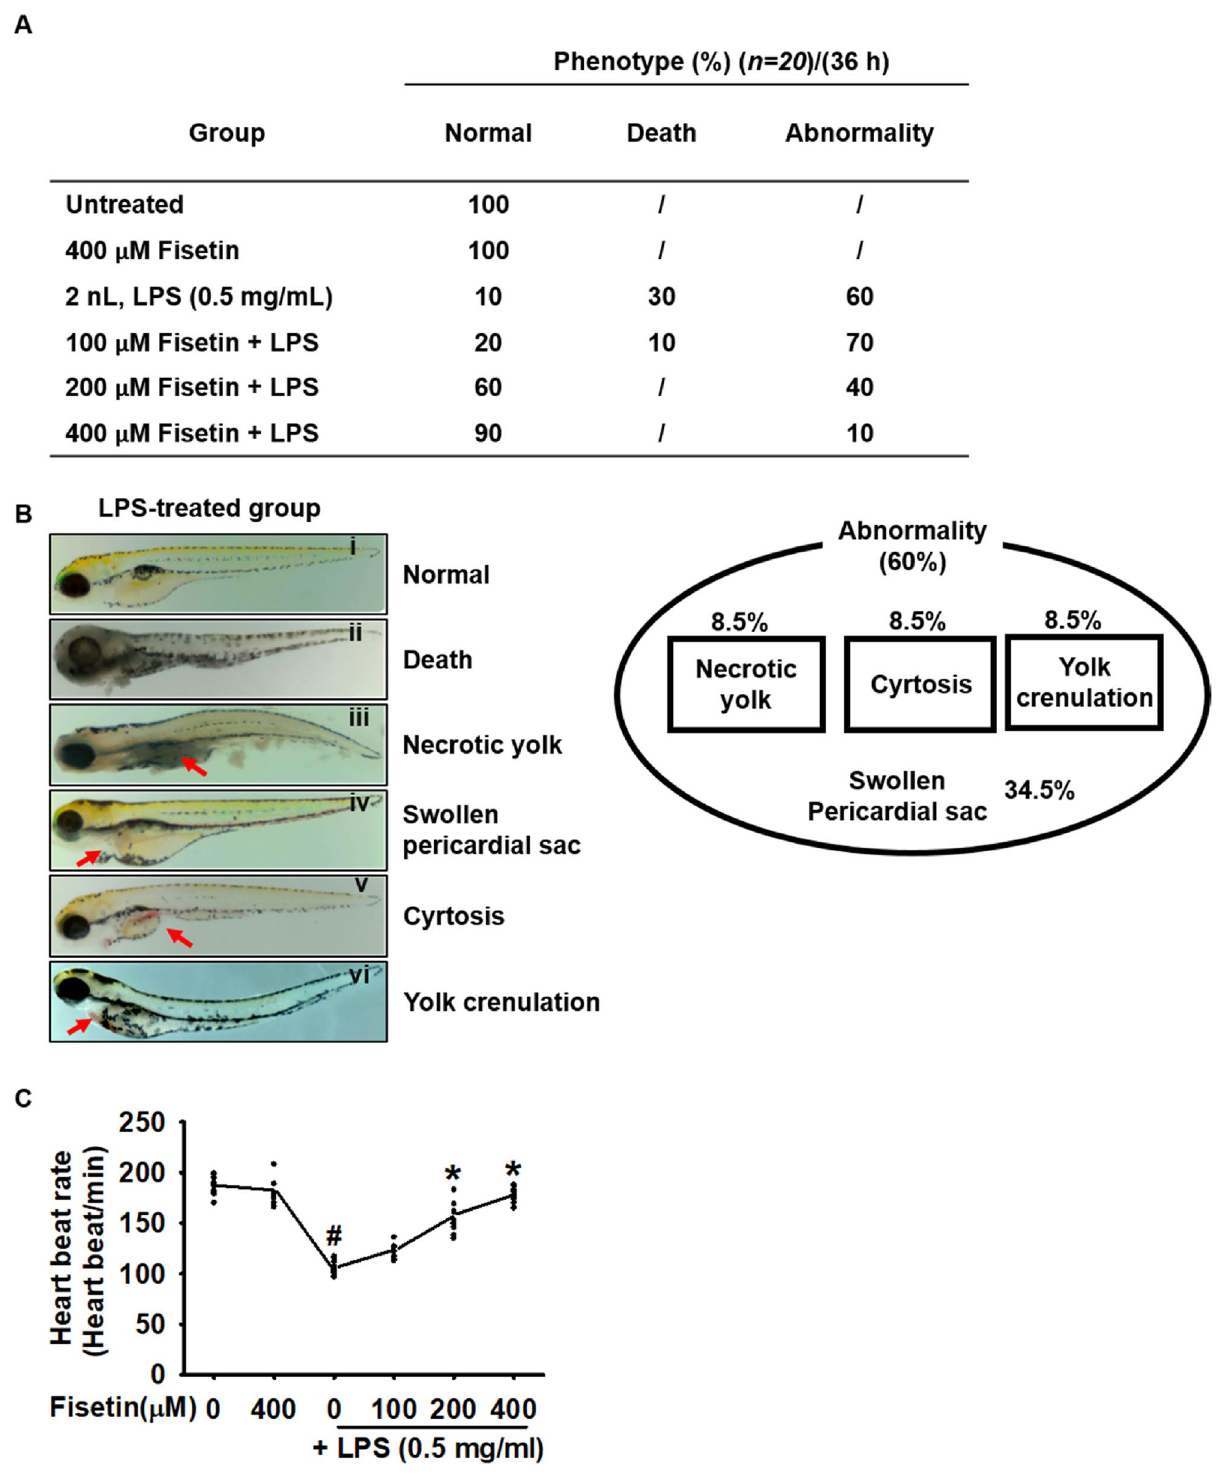
Figure 3. Fisetin attenuates LPS-induced mortality, abnormalities, and lowered heart rate in zebrafish larvae. Zebrafish larvae at 3 dpf ( n = 20) were microinjected with 2 nL of 0.5 mg/mL LPS and immediately immersed in the indicated concentrations of fisetin. ( A ) Phenotype-based evaluations were performed at 36 h post injection (hpi). ( B ) LPS-microinjection increases abnormalities in zebrafish larvae at 36 hpi; this was observed using stereomicroscopy; (i) normal, (ii) death, (iii) necrotic yolk, (iv) swollen pericardial sac, (v) cyrtosis, and (vi) yolk crenulation. ( C ) LPS microinjection induces 60% abnormalities of zebrafish larvae and all larvae exhibits swollen pericardial sac (34.5%) either alone or together with necrotic yolk (8.5%), cyrtosis (8.5%), or yolk crenulation (8.5%). ( D ) Heart rates were measured to assess toxicity. Each value indicates the mean ± standard error median (SEM), and is representative of the results obtained from 20 fish for each group. Significant differences among the groups were determined using Student’s t -test ( # p < 0.01 vs. untreated zebrafish larvae) and one-way ANOVA with Bonferroni correction (* p < 0.01 vs. LPS-treated zebrafish